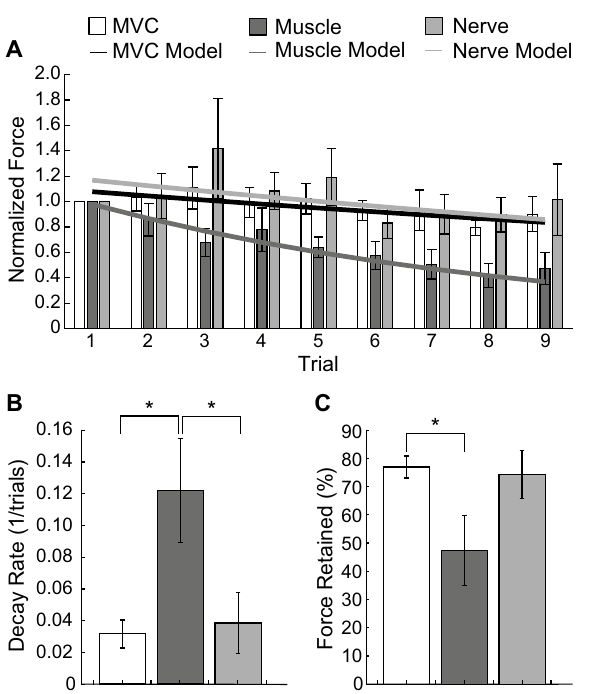
Figure 7. Nerve trunk stimulation resulted in a slower fatigue rate. ( A ) The bars indicate the maximum force of each trial normalized by the first trial of each experimental block, then averaged across participants, and the lines indicate the resulting exponential fatigue model fit. The black line represents the MVC fatigue model, the dark gray line represents the muscle fatigue model, and the light gray line represents the nerve fatigue model. ( B ) Muscle stimulation (dark gray bar; n = 8) resulted in a significantly faster exponential decay rate (paired t-test: p < 0.05) compared to nerve stimulation (light gray bar; n = 8) and MVC (white bar; n = 8). ( C ) Muscle stimulation (n = 7) also had a significantly lower force retention between the first and last trials (unpaired t-test: p = 0.05) than MVC (n = 8). Bars show mean ± standard error of the mean. Asterisks denote statistical significance using the tests described